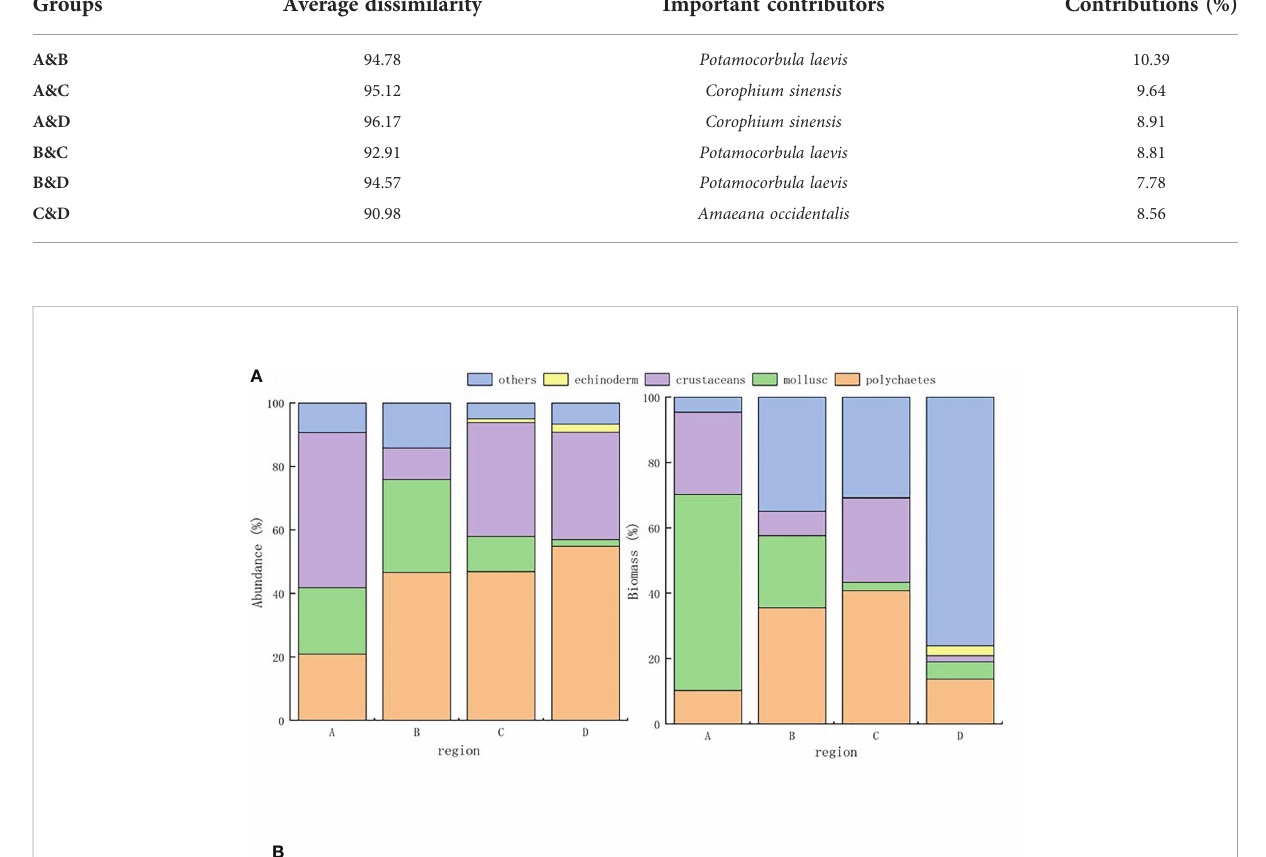
Percentage values (%) of macrobenthos abundance and biomass in different regions of Hangzhou Bay are presented in Figure 3A. For region A, crustaceans were most abundant (the amphipod Corophium sinensis reached 80 ind m − 2 ), and mollusk biomass was highest (bivalve biomass reached 0.4 g m − 2 ). The abundance ratio of polychaetes in regions B, C and D was